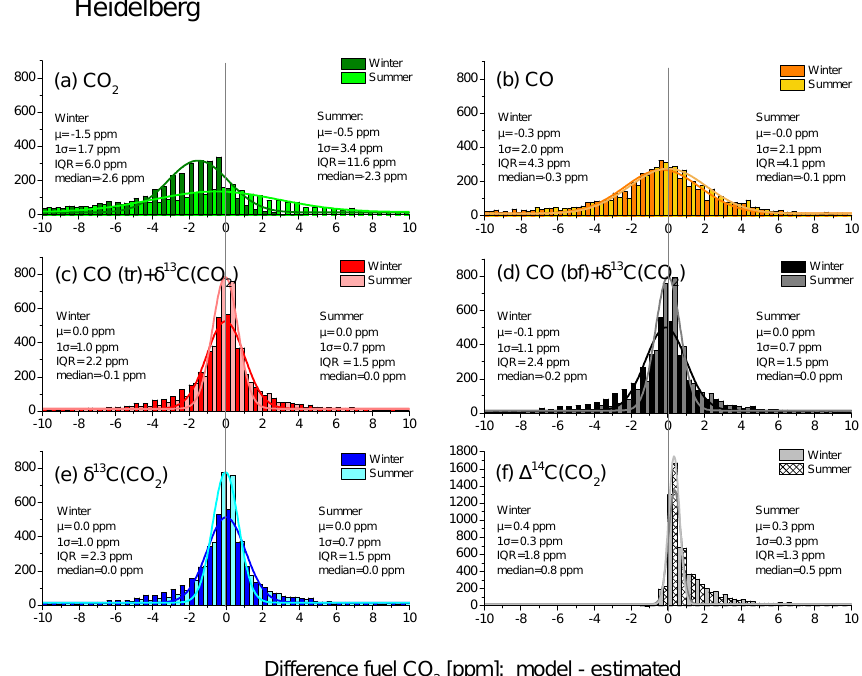
Figure 1. Histograms showing the differences between the modeled fuel CO 2 (assumed as correct) and the tracer-based estimated fuel CO 2 for the year 2012 for Heidelberg using the different tracers and tracer configurations listed in Table 2. Differences result from sub-monthly variations of parameters. Note the different y axis scale. Darker colors denote the winter periods and lighter colors the summer periods (see legend). The distributions were fitted with a Gaussian fit and the shift ( µ) and the standard deviation ( σ) for the Gaussian fits are given in the figure. Since the histograms do not follow Gaussian distributions (especially for 14 C(CO 2 ) due to non-normally distributed biofuel CO 2 contributions within 1 year) we also give the interquartile range (IQR) in the figure to remind the reader that the uncertainty may be underestimated when using the Gaussian standard deviation for uncertainty analysis. The CO 2 mole fractions are given in parts per million (ppm), which is equivalent to µmolmol − 1 . Note that, in Heidelberg, mean fuel CO 2 for summer is 15µmolmol − 1 and that for winter is 16µmolmol − 1